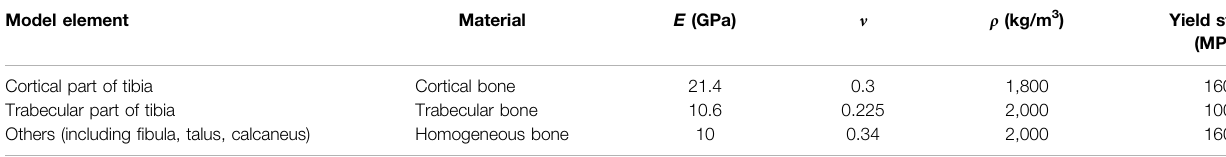
TABLE 1 | Material parameters selected for individual model elements.